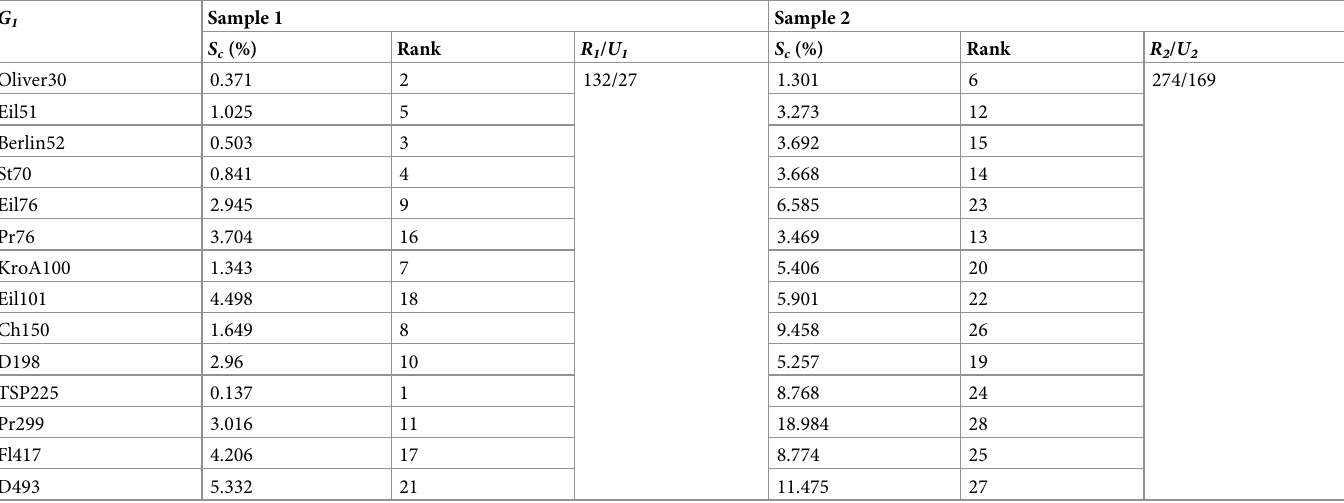
Table 4. S c and rank of DSRABSQL and VDWOA algorithms in G 1 .